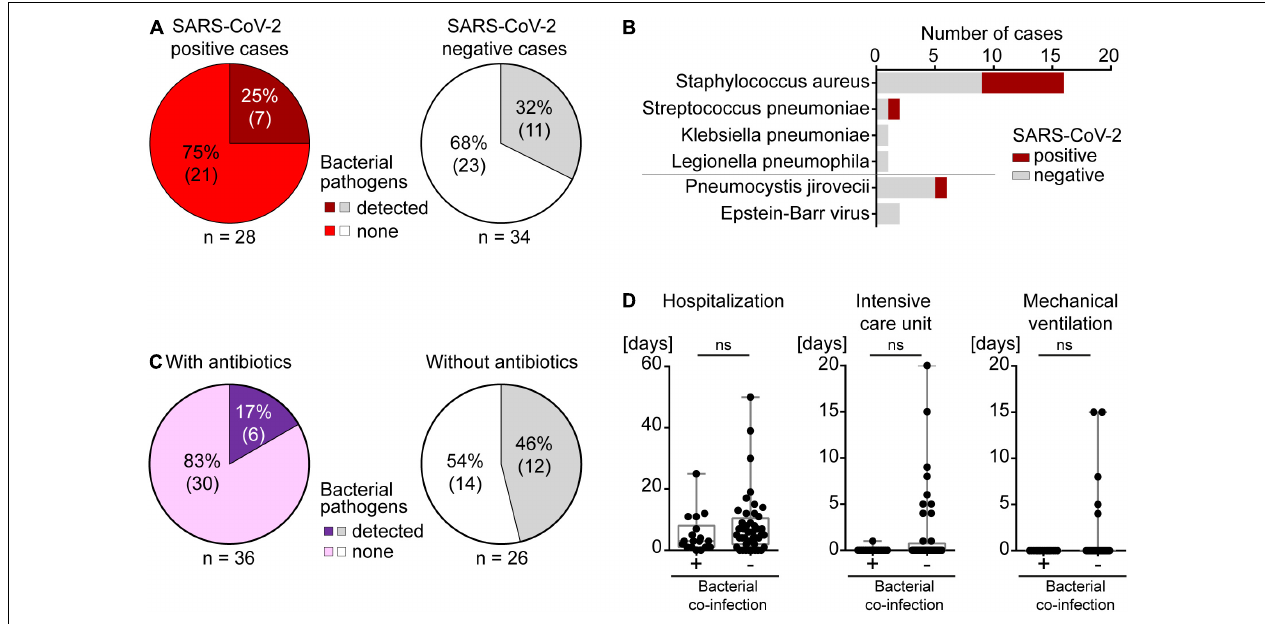
FIGURE 4 | Co-infections in autopsy cases. (A) Left , SARS-CoV-2 positive and right , SARS-CoV-2 negative patients. (B) Types of co-infections identified in the autopsy cohort of SARS-CoV-2 positive and negative patients. (C) Left , bacterial co-infections in individuals with antibiotic treatment. Right , bacterial co-infections in individuals without antibiotic treatment. (D) Bacterial co-infections in relation to duration of hospitalization, ICU care or mechanical ventilation.